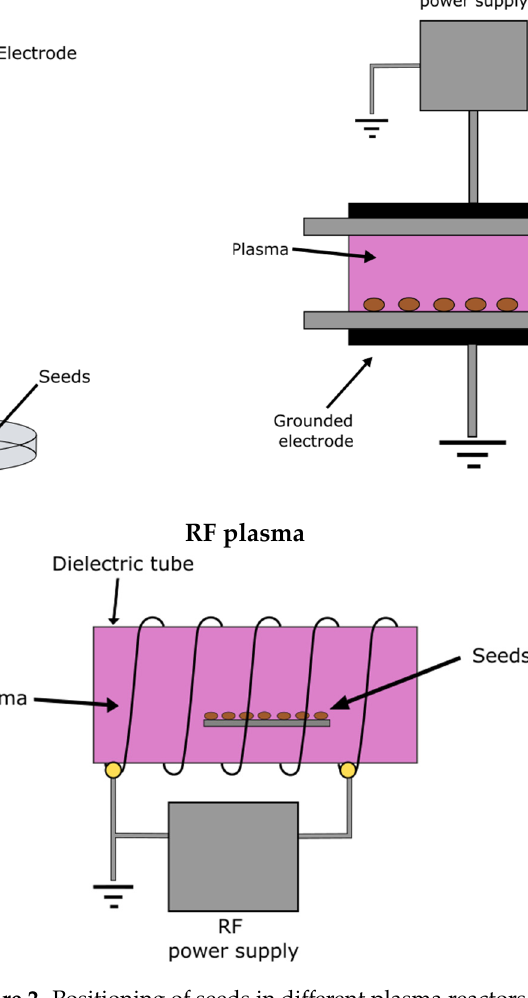
Figure 2. Positioning of seeds in different plasma reactors.